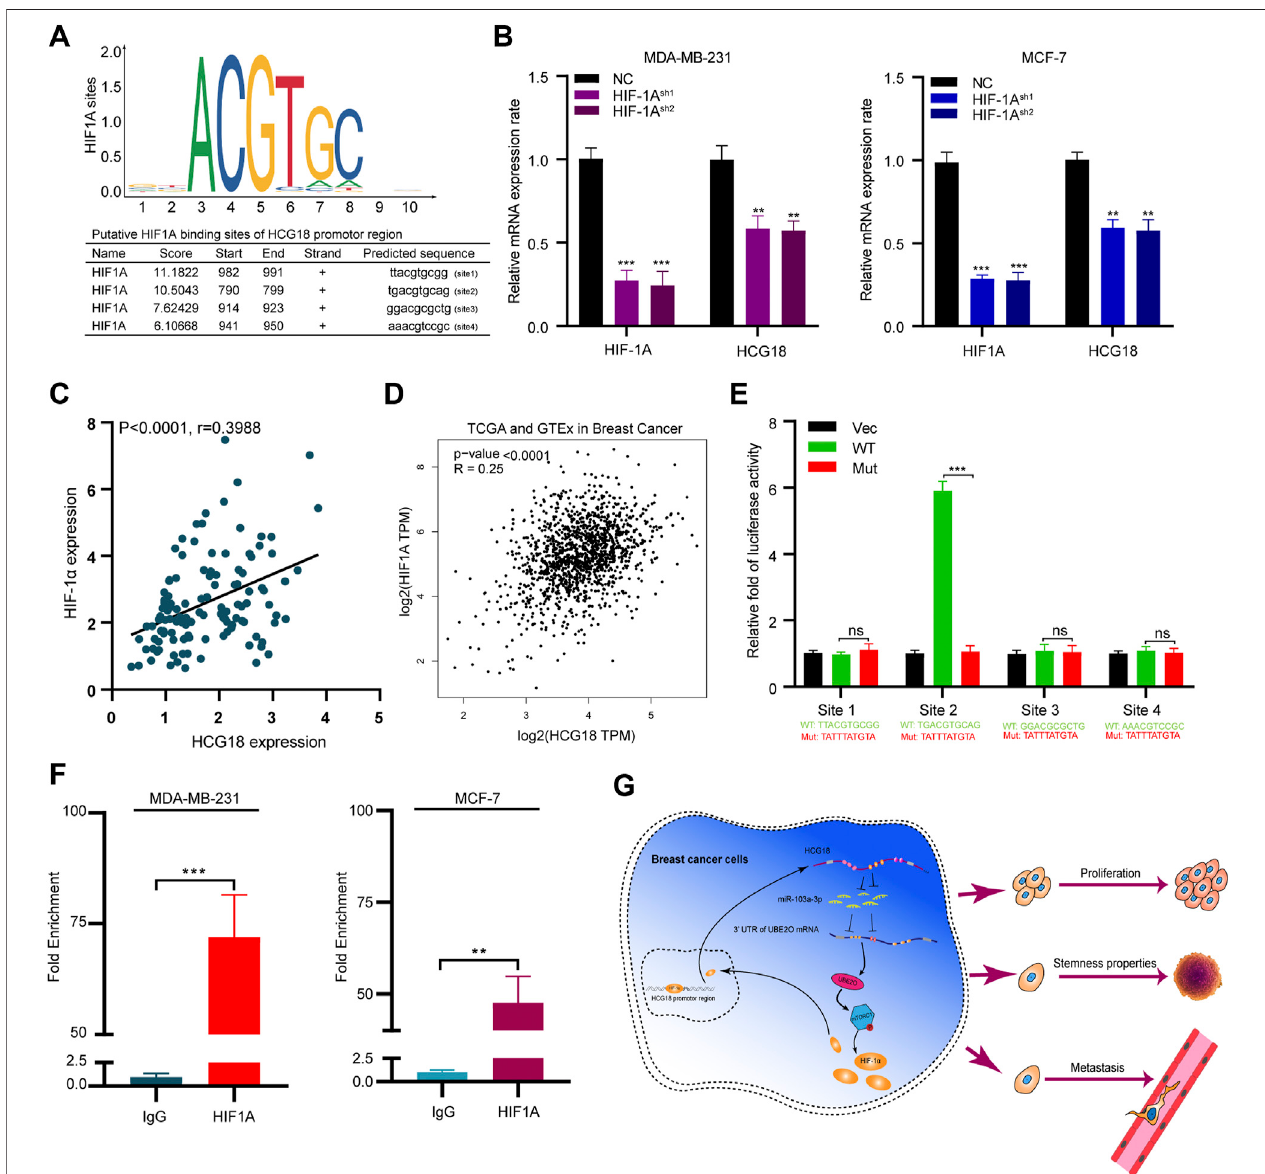
Figure S2H revealed that the decreased expression of Figure S2F ), and scratch assays E-cadherin and increased expression of vimentin, MMP-2, MMP-9, CD44, and OCT4 were remarkably reversed by miR-103a-3p mimics. Taken together, these results claimed that HCG18 promoted UBE2O expression by sponging miR- 103a-3p in human